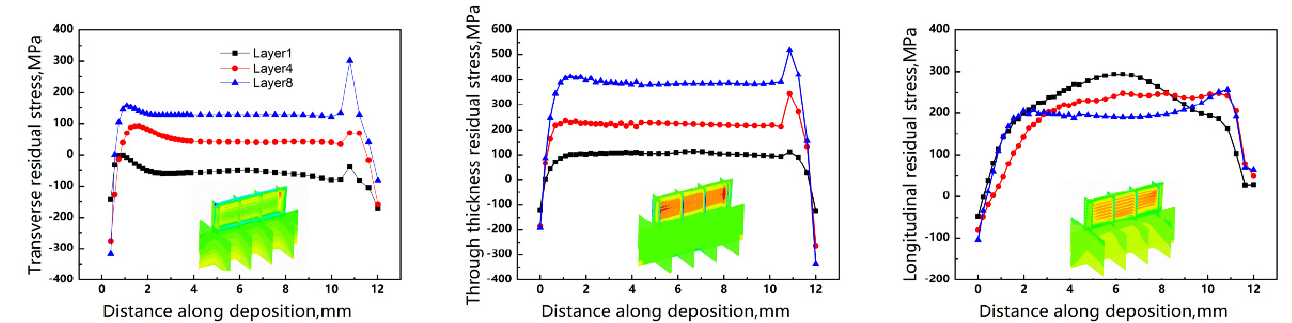
Figure 5. The XX, YY, and ZZ stresses for Layer 1, Layer 4, and Layer 8 under a scanning speed of 16 mm/s, a laser power of 400 W, and a layer thickness of 400 µ m.